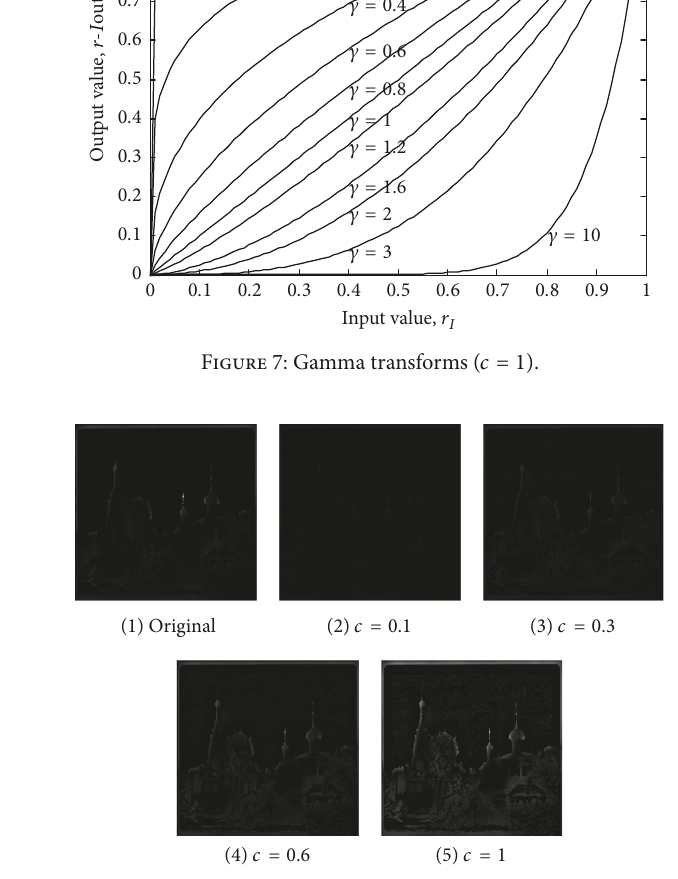
Figure 8: Reflection component enhanced by different 𝑐